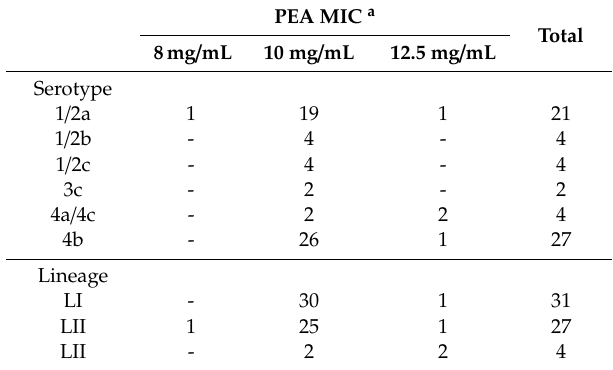
Figure 1. Evaluation of β -phenylethylamine (PEA) inhibitory effect against L. monocytogenes . ( A ) Growth curves of L. monocytogenes EGDe in brain heart infusion (BHI) broth supplemented with increasing PEA concentrations at 37 °C. Presented are growth curves from a representative reference strain EGDe plotted from mean OD 600 measurement from three replicate experiments observed from kinetic growth assays in BHI supplemented with PEA. ( B ) Distribution of PEA minimum inhibitory concentrations with respect to serotypes and genetic lineages (L) of the 62 L. monocytogenes strains examined. Table 2. Serotype, lineage, and PEA MICs.